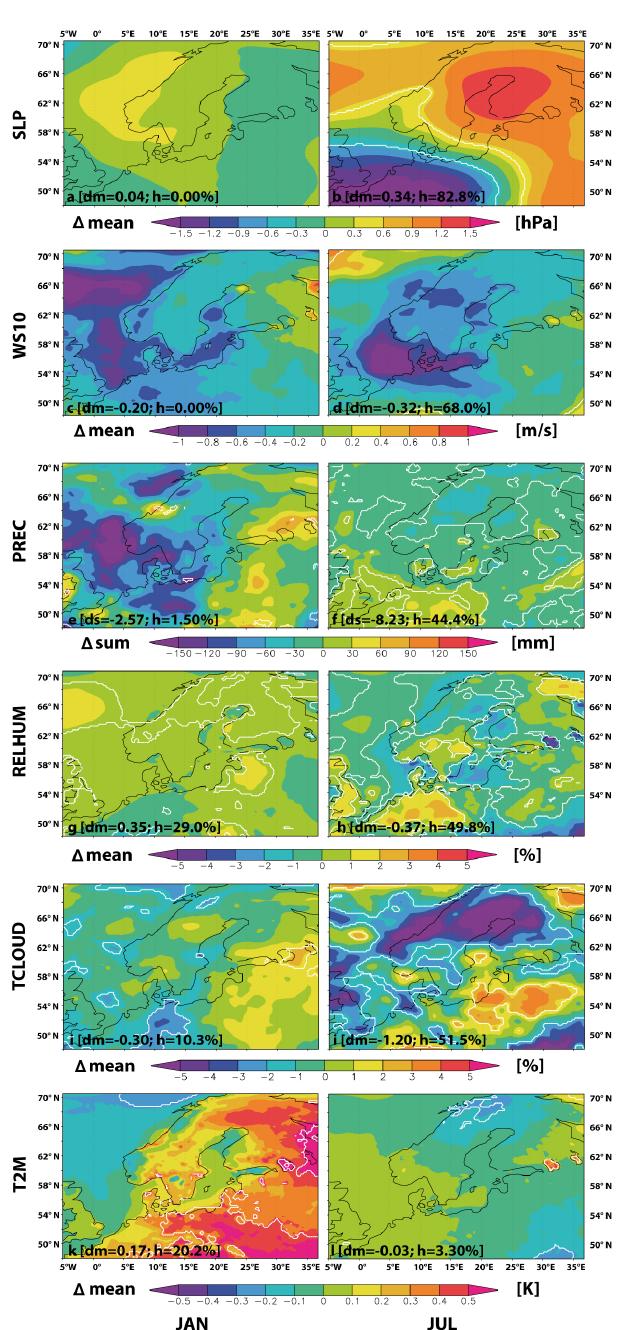
Fig. 8. Mean bias of HiResAFF minus the reference fields of RCAO (RCAX for T2M) for January (left column) and July (right col- umn) 1958–2007. White shaded lines indicate areas where the re- construction shows significant bias in mean with p <